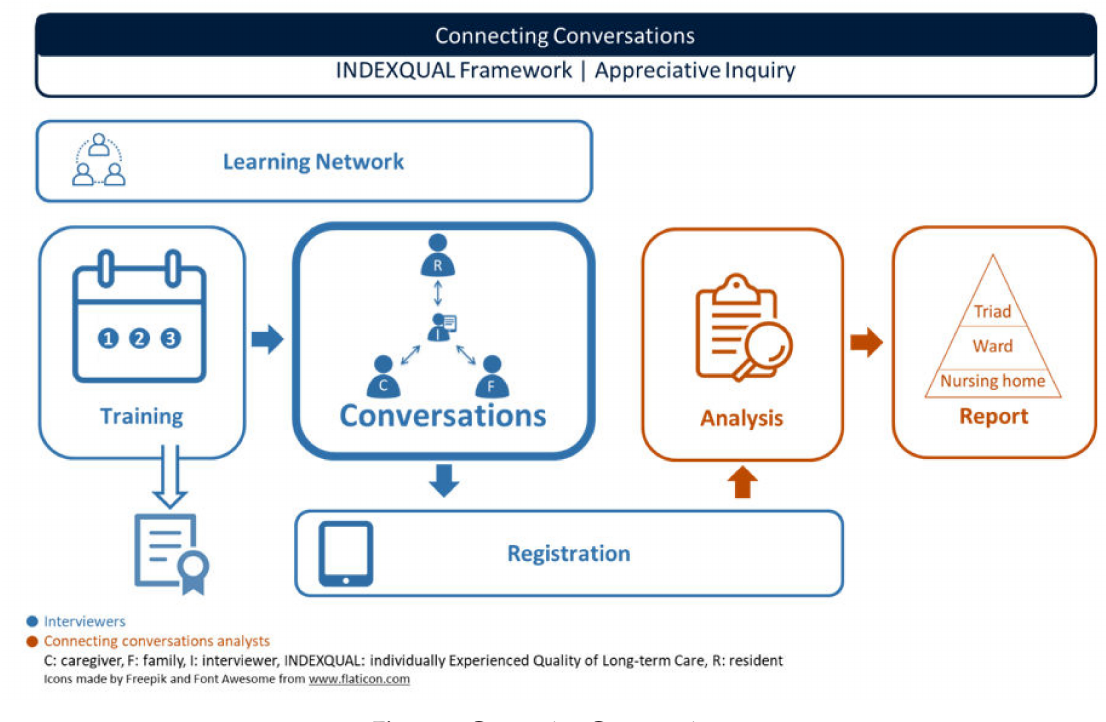
Figure 1. Connecting Conversations. Table 1. A summarized description of the Connecting Conversations